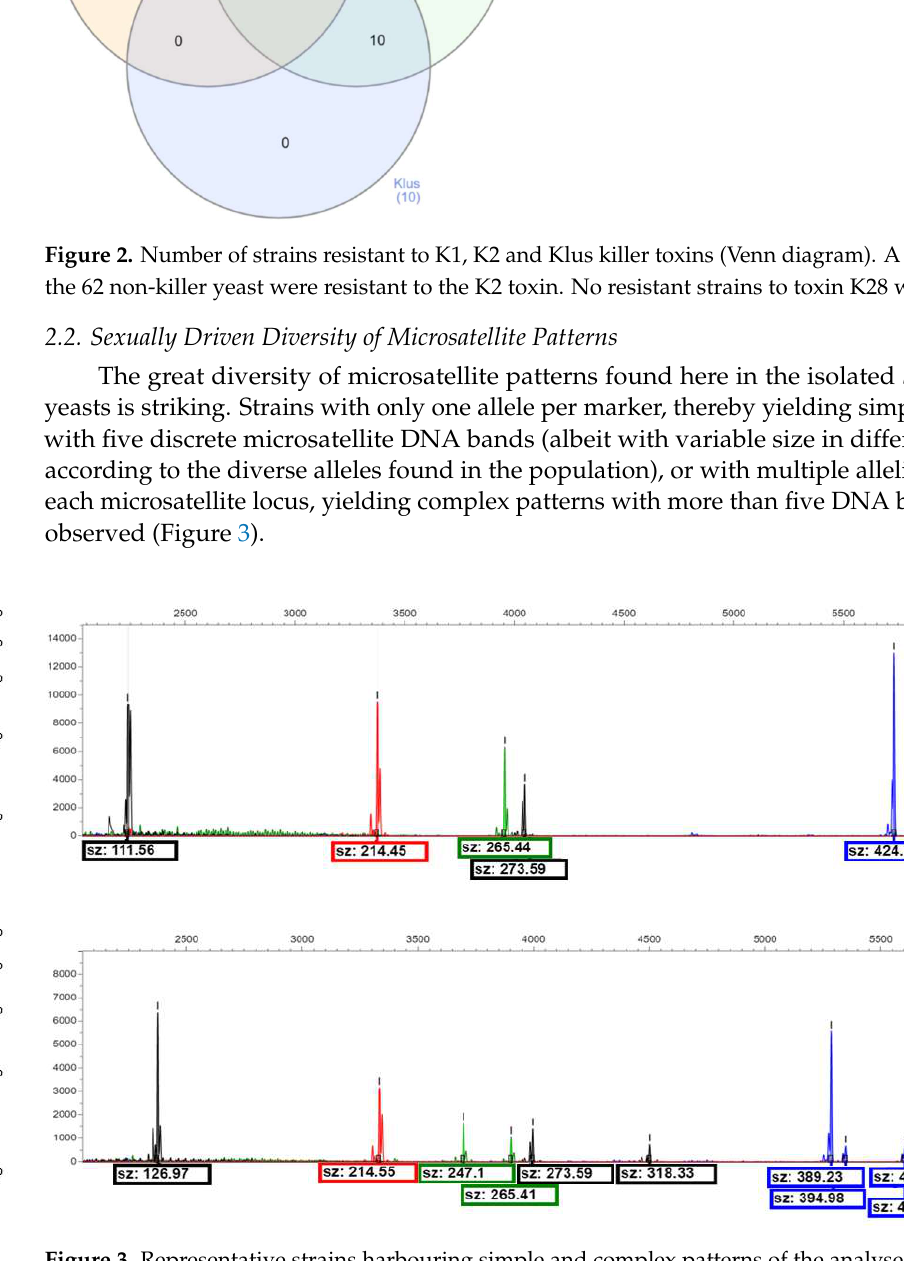
Figure 3. Representative strains harbouring simple and complex patterns of the analysed microsatellite loci. ( A ) Simple pattern yielding five discrete microsatellite DNA bands in gel electrophoresis ( left ), accurately identified by capillary electrophoresis using labelled primers to identify each of the five microsatellite bands ( right ). ( B ) Complex pattern (polymorphic strain with a complex genome ploidy) yielding more than five discrete microsatellite DNA bands in gel electrophoresis ( left ) and capillary electrophoresis ( right ) as described in A. Capillary electrophoresis peaks are colour labelled to distinguish microsatellite loci (leftmost black, C5; red, SC8132X; green, ScAAT3; rightmost black SCPTSY7and blue, SCYOR267C). sz = size, MW = DNA size